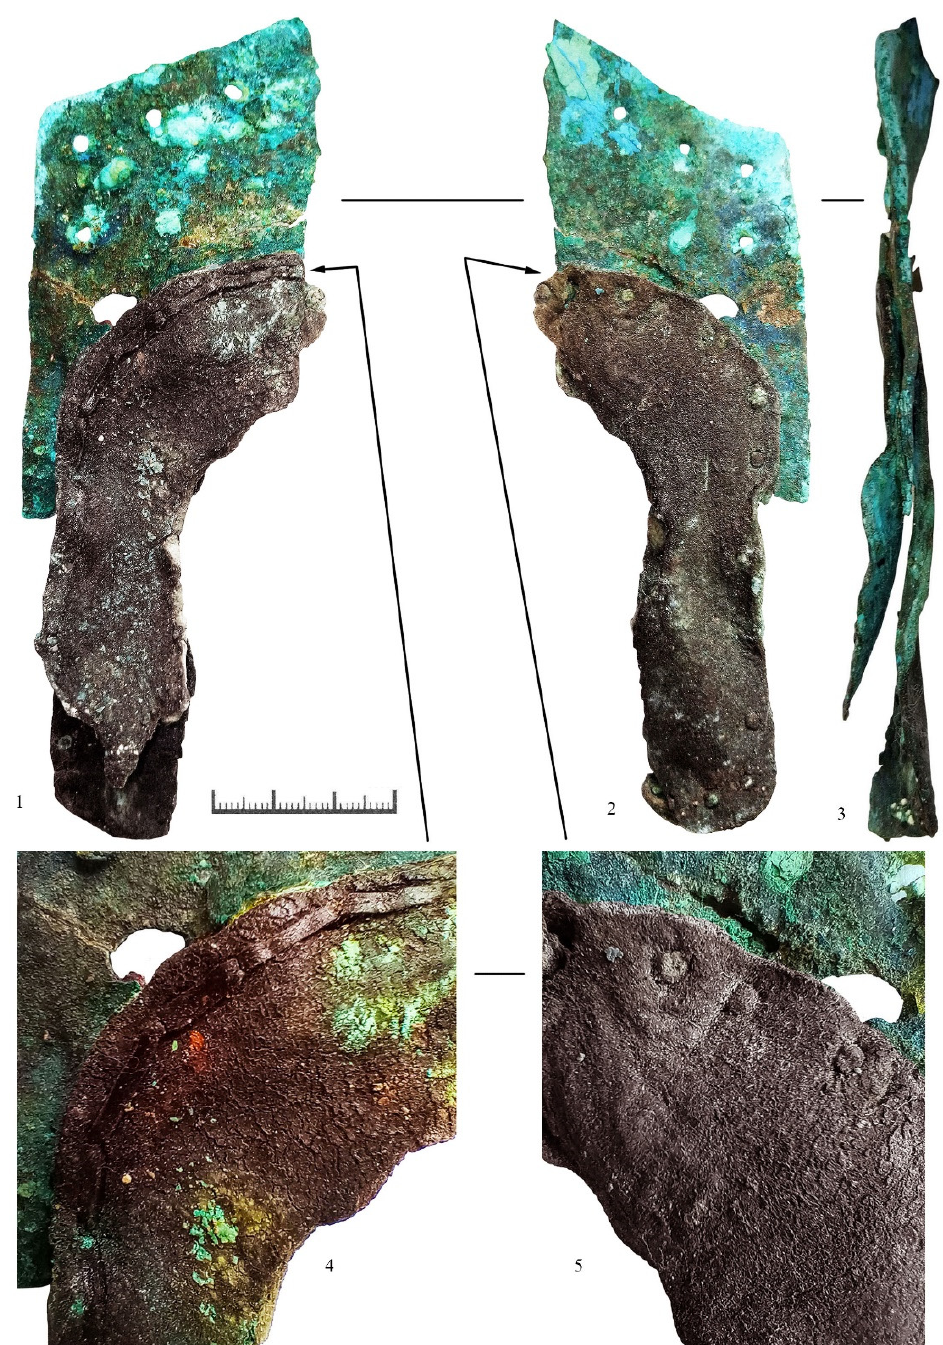
Figure 4. Vodoslavka Barrow 6 Burials 1–2. The left greave. (1), (4)—Fragment of the right side corner of the greaves on the side adjacent to the body of the horse. External side; (2), (5)—A right side-angle from the outer side of the right greave. Inner side; (3)—Lateral view (photograph М . Daragan). 3. A fragment of the upper left corner from the inner side of the left greave, measuring 9.3 × 8 cm (Figure 6(1)). At 0.5 cm from the edge, a series of small holes with a diameter 0.3 cm was pierced at an interval of 0.4–1.6 cm (with filed down burrs around the holes remaining on the exterior). The holes were for sewing the lining of the